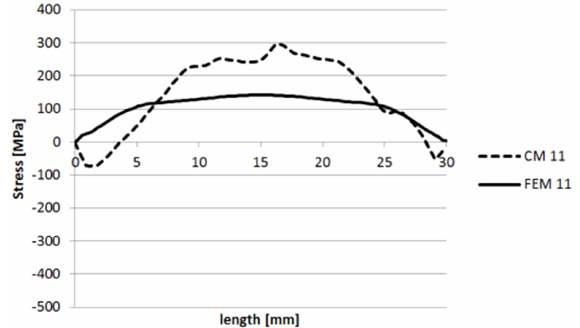
Figure 53. Stress levels in 11 direction along the AB line